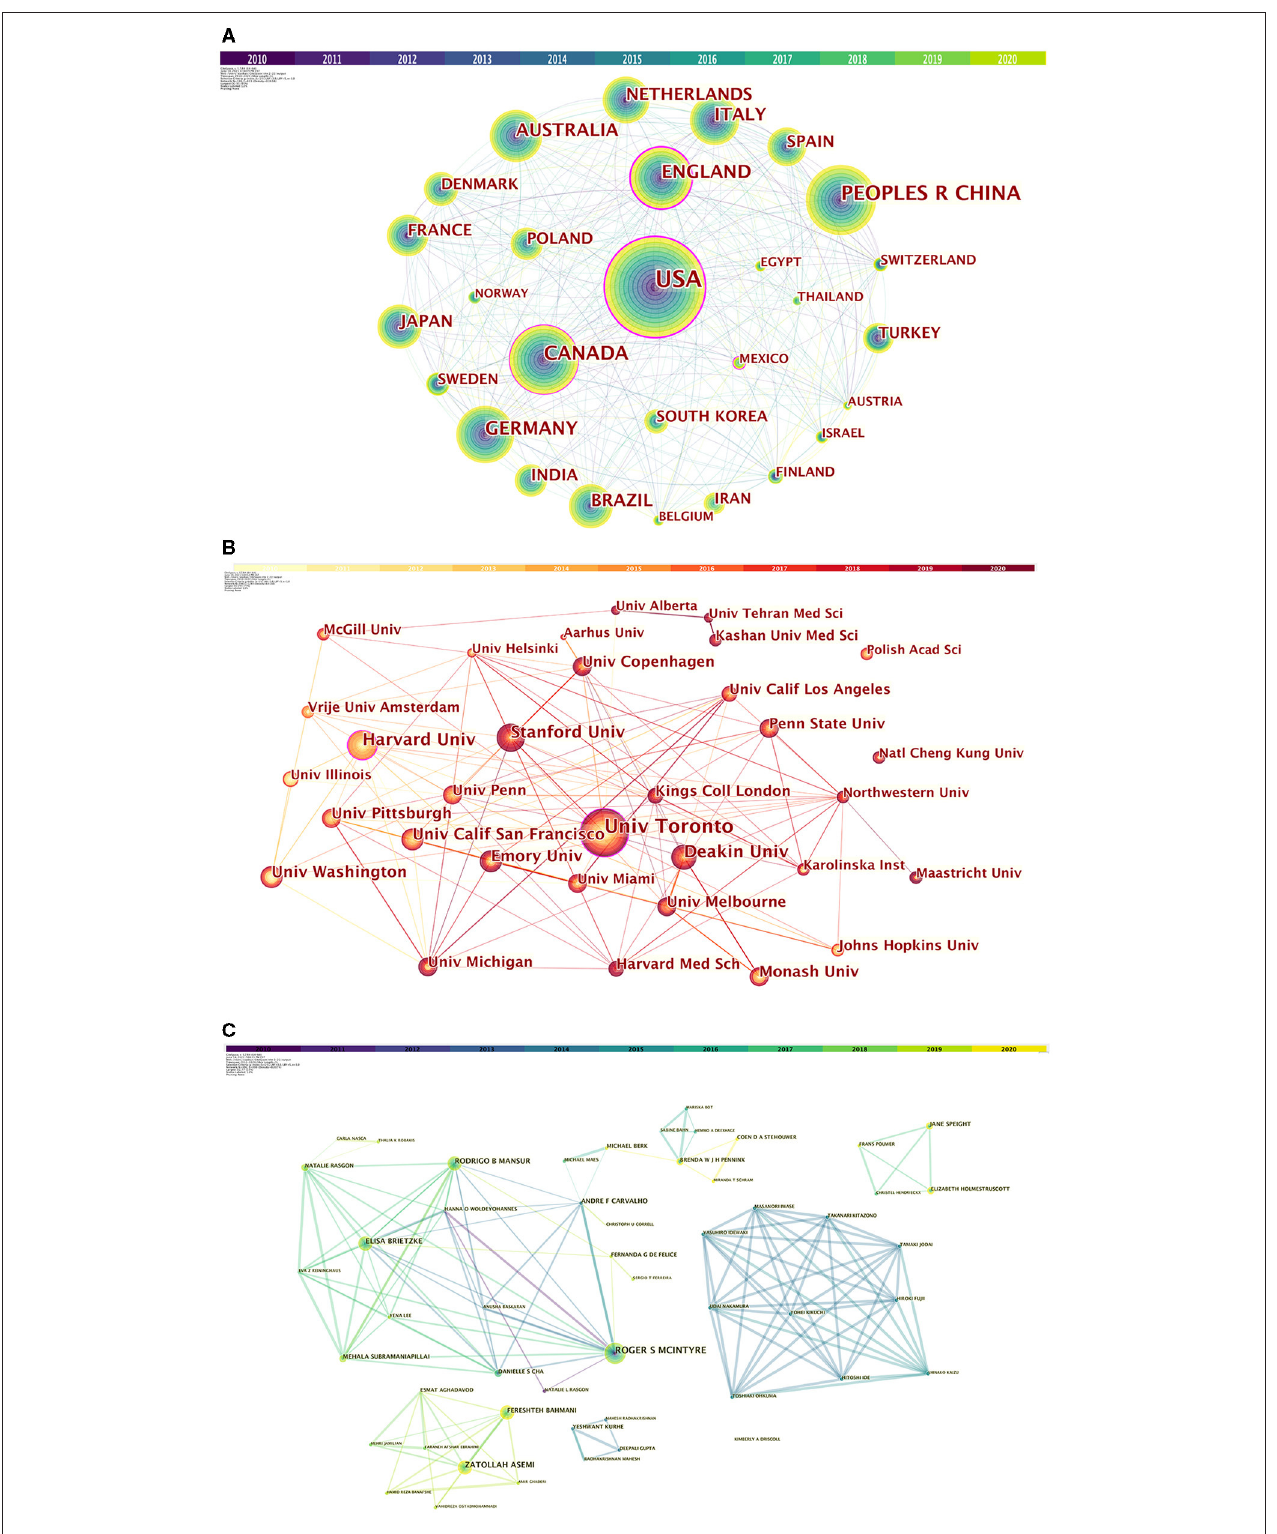
FIGURE 3 | (A) Collaboration among countries/regions. (B) Collaboration among institutions. (C) Collaboration among authors.